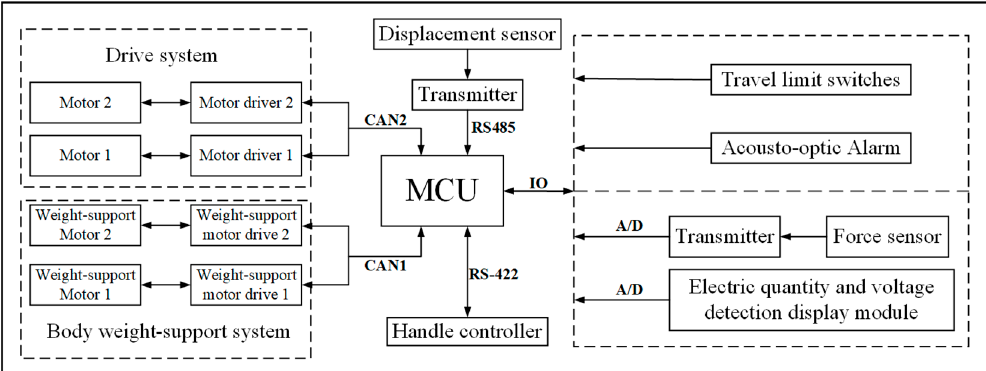
Figure 6. Hardware system framework of the rehabilitation robot.